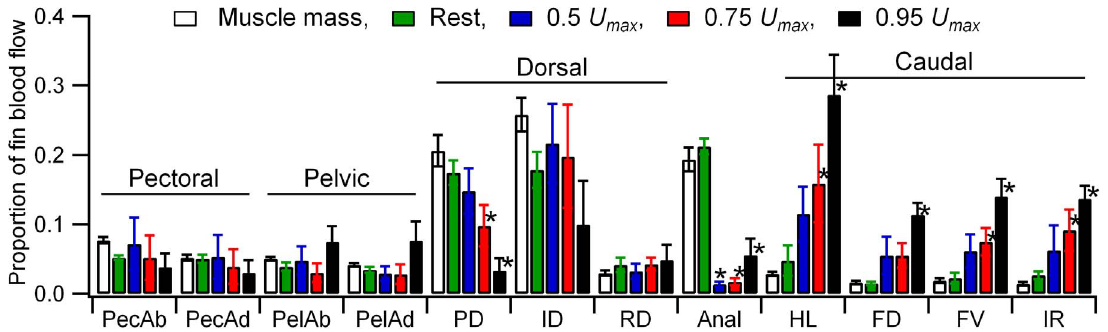
Figure 3. Proportional distribution of blood flow within the fin musculature. Flows are expressed as a proportion of the total blood flow directed to the fin musculature. Muscle mass is expressed as a proportion of the total muscle mass. * denotes a significant difference between the blood flow and muscle mass proportions based on a planned contrasts procedure using muscle mass as the comparison group (p , 0.05). Data are shown as mean 6 sem (N=6 to 8). Muscles are as follows: PecAb, pectoral fin abductors; PecAd, pectoral fin adductors; PelAb, pelvic fin abductors; PelAd, pelvic fin abductors; PD, protractor dorsalis; ID, inclinator dorsalis; RD, retractor dorsalis; Anal, anal fin musculature; HL, hypochordal longitudinalis;FD, flexor caudalis dorsalis; FV, flexor caudalis ventralis; IR, interfilamenti caudalis.